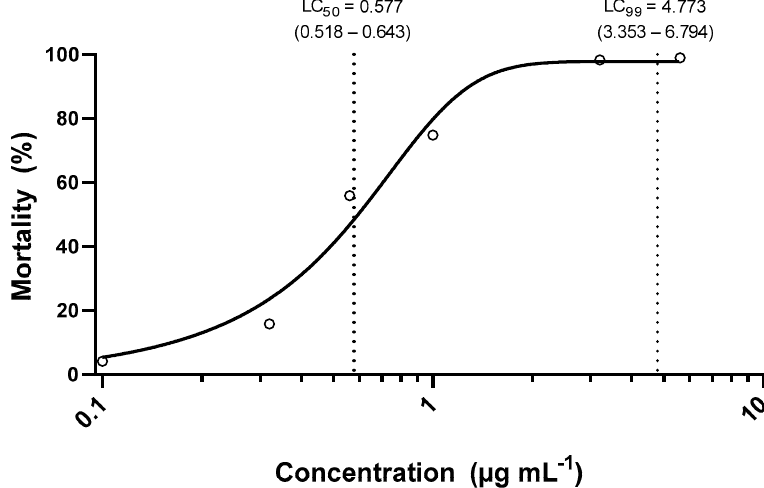
Figure 1. Concentration-response curve of the Spodoptera frugiperda susceptible strain (Sf-ss) to teflubenzuron.